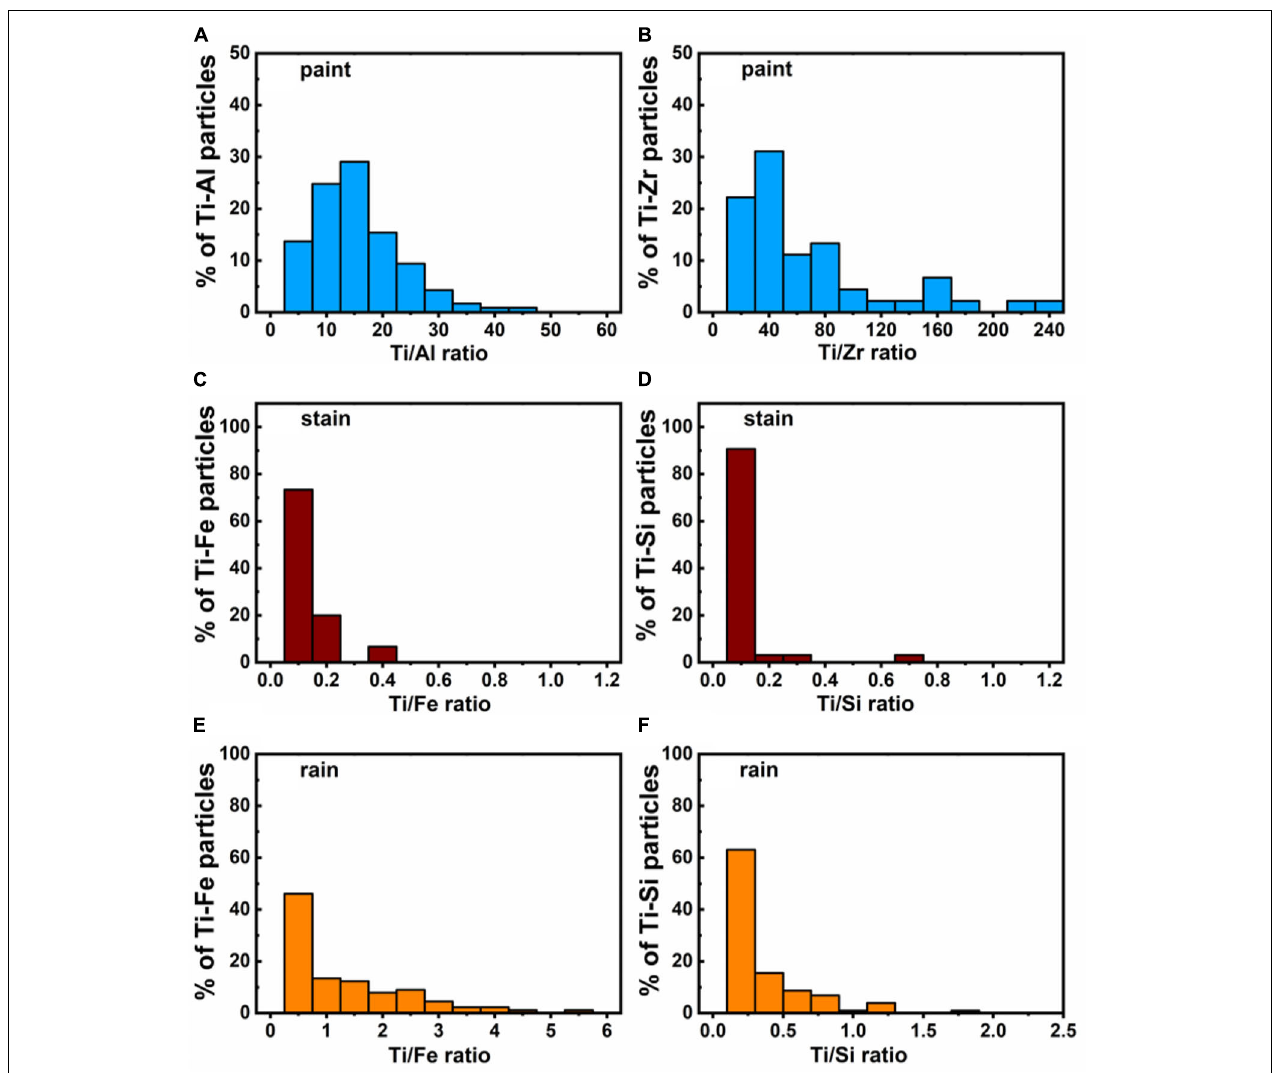
FIGURE 7 | Elemental mass ratios measured on individual particles for major associations of the Ti in (A,B) liquid paint, (C,D) liquid stain and (E,F) Montreal rain samples. Measurements were performed using a SP-ICP-TOF-MS.